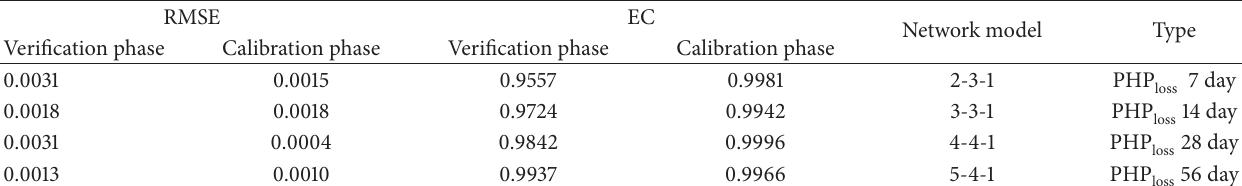
Table 3: The results of PHP modeling method based on artificial neural networks. loss